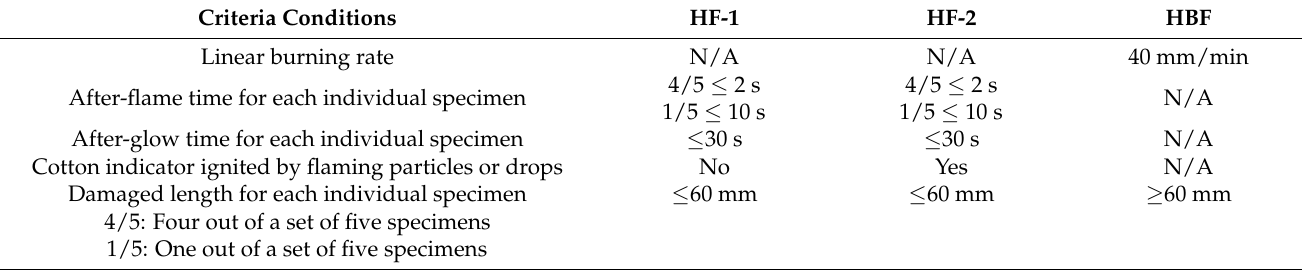
Table 1. Classifications of the burning behavior according to KS M ISO